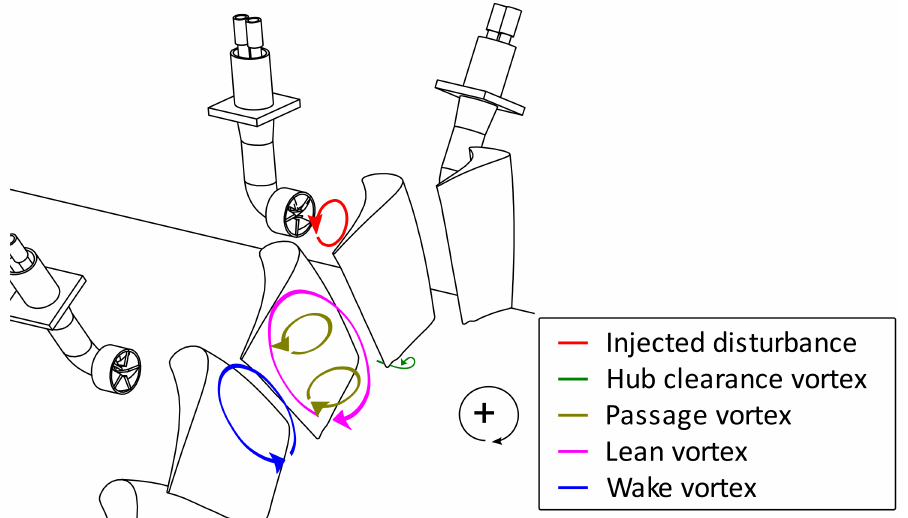
Figure 9. Vortical structures stator downstream.